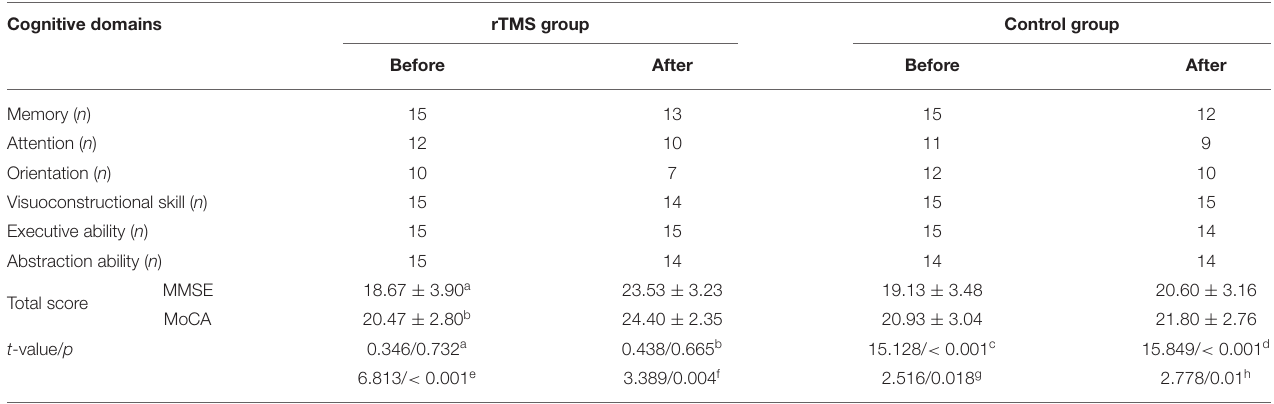
TABLE 2 | Details of cognition tests.